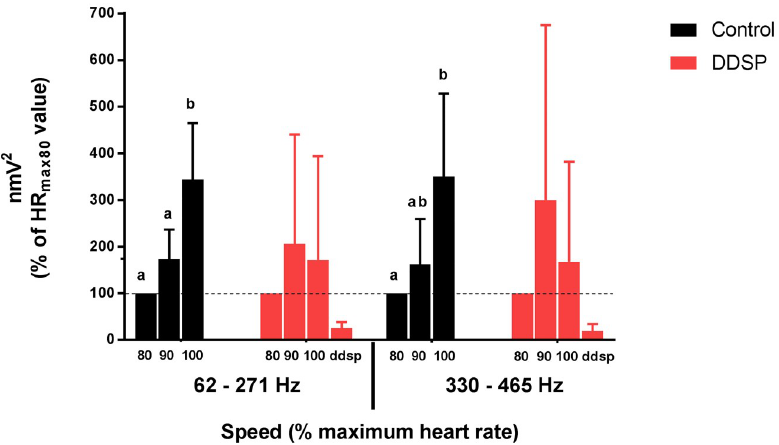
Fig 6. Exercise induced variation in intensity of the two frequency domains identified after wavelet decomposition of the thyro-hyoid muscles electrical activity during exercise. The control group (black bars) showed a significant increase in the intensity of the two frequency domains during exercise, reaching the maximum value at HR max100 . The DDSP group (red bars) showed a non-significant initial increase followed by a non-significant decrease in the intensity of both domains during exercise. Intensity of each frequency domain is normalized to the value recorded at exercise intensity corresponding to HR max80 (nmV 2 ). Data are expressed as mean ± SD. Different letters indicate statistically significant difference between intensity values recorded at different speed intervals.